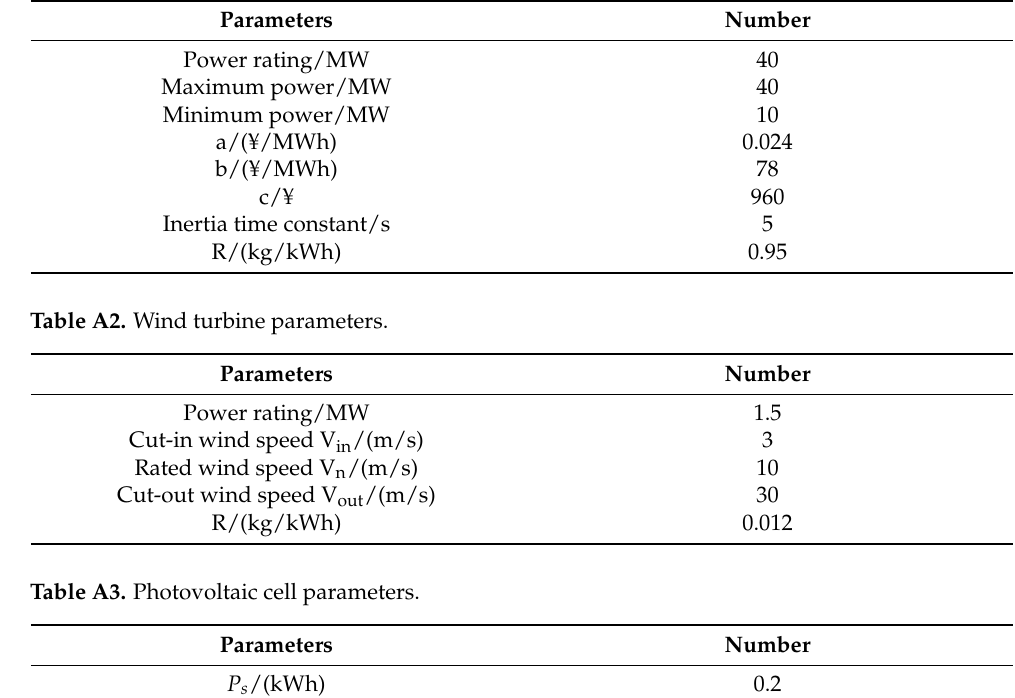
Table A1. Thermal power unit parameters.